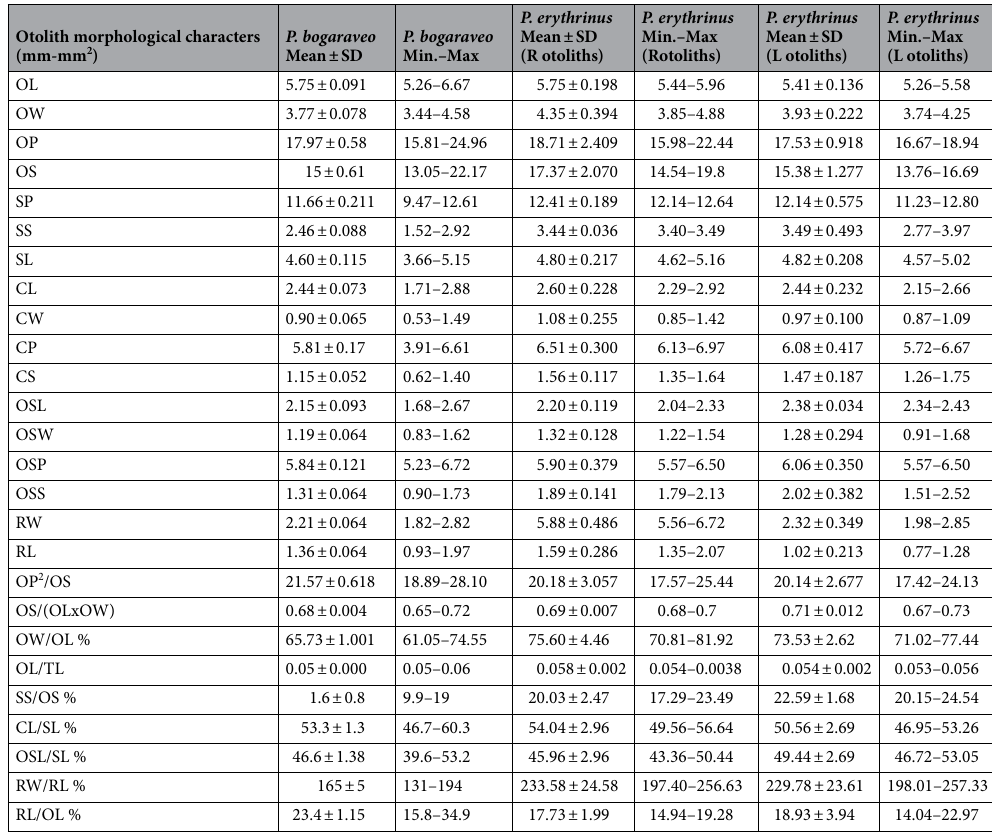
Table 1. Morphometric mean values with standard deviation (SD) and range of P. bogaraveo and P. erythrinus juvenile group individuals: OL (otolith length), OW (otolith width), OP (otolith perimeter), OS (otolith surface), SP (sulcus perimeter), SS (sulcus surface), SL (sulcus length), SW (sulcus width), CL (cauda length), CW (cauda width), OSL, (ostium length), OSW (ostial width), RW (rostrum width), RL (rostrum length), CI (circularity), RE (rectangularity), aspect ratio (OW/OL %), the ratio of otolith length to total fish length (OL/TL), percentage of the otolith surface occupied by the sulcus (SS/OS%), percentage of the sulcus length occupied by the cauda length (CL/SL%), percentage of the sulcus length occupied by the ostium length (OSL/ SL%), rostrum aspect ratio (RW/RL%) and percentage of the rostrum length occupied by the otolith length (RL/OL%). The morphometric data of Pagellus bogaraveo shown in the table relate only to the left otolith since no significant difference was found between the left (L) and right (R)